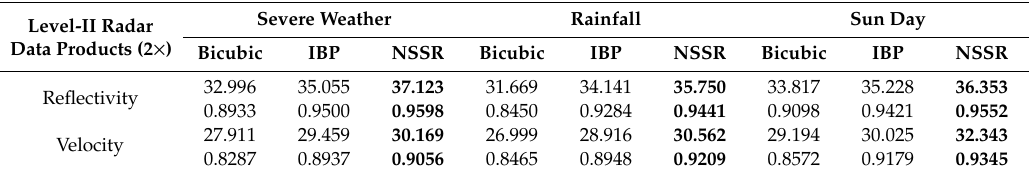
Table 2. Average PSNR (dB) and SSIM results of the reconstructed echo of five groups of level-II CINRAD SA data.